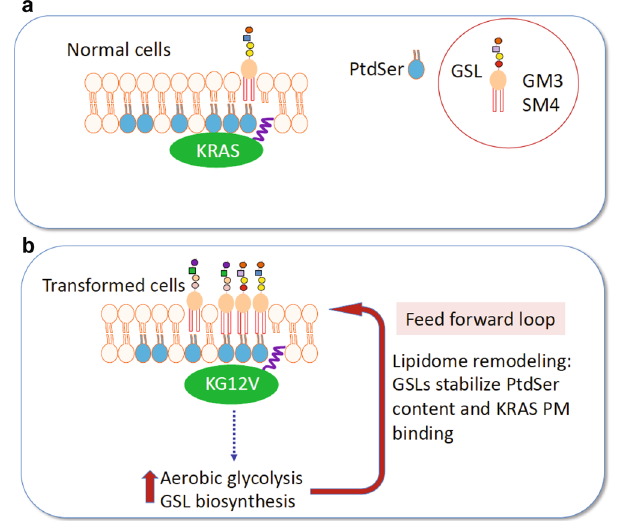
Fig.7|PositivefeedbackloopbetweenoncogenicKRASandglycosphingolipid biosynthesis. A subset of outer lea fl et glycosphingolipids, GM3 and SM4,